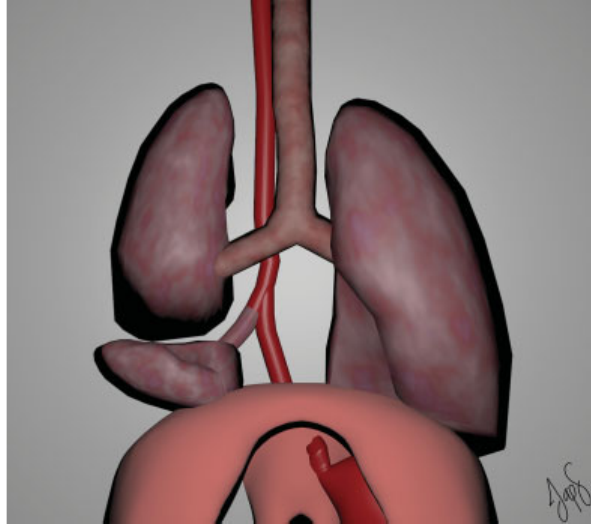
Fig. 4 Three-dimensional (3D) model of esophageal lung type III by Srikanth et al classi fi